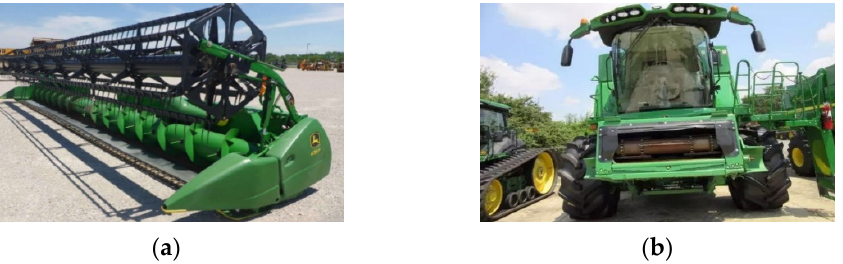
Figure 9. John Deere S660 combine harvester. ( a ) Removable header; ( b ) the machine after removing the header.